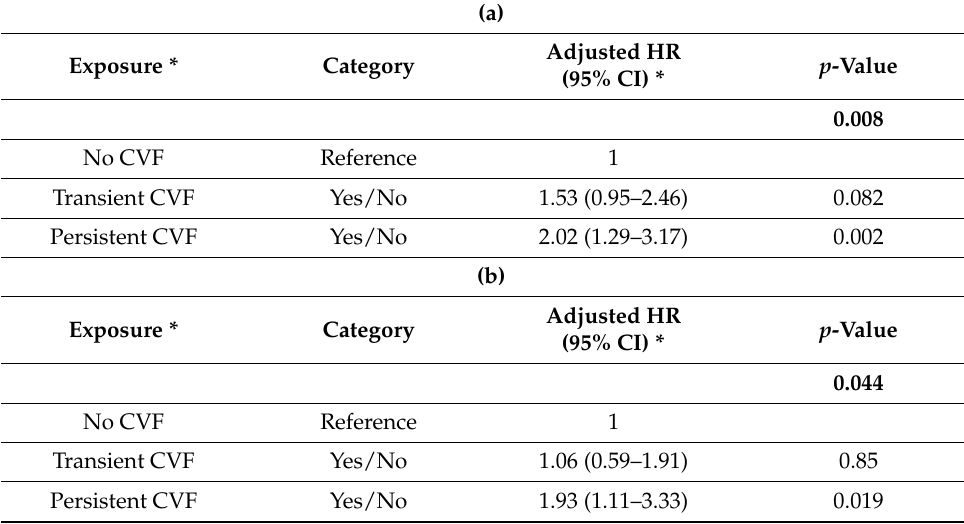
Figure 2. Adjusted survival curve for 90-day mortality in accordance with the presence of cardiovascular failure in patients with microbiologically confirmed ICUAP. Table 8. Multivariate Cox regression for 90-day mortality.